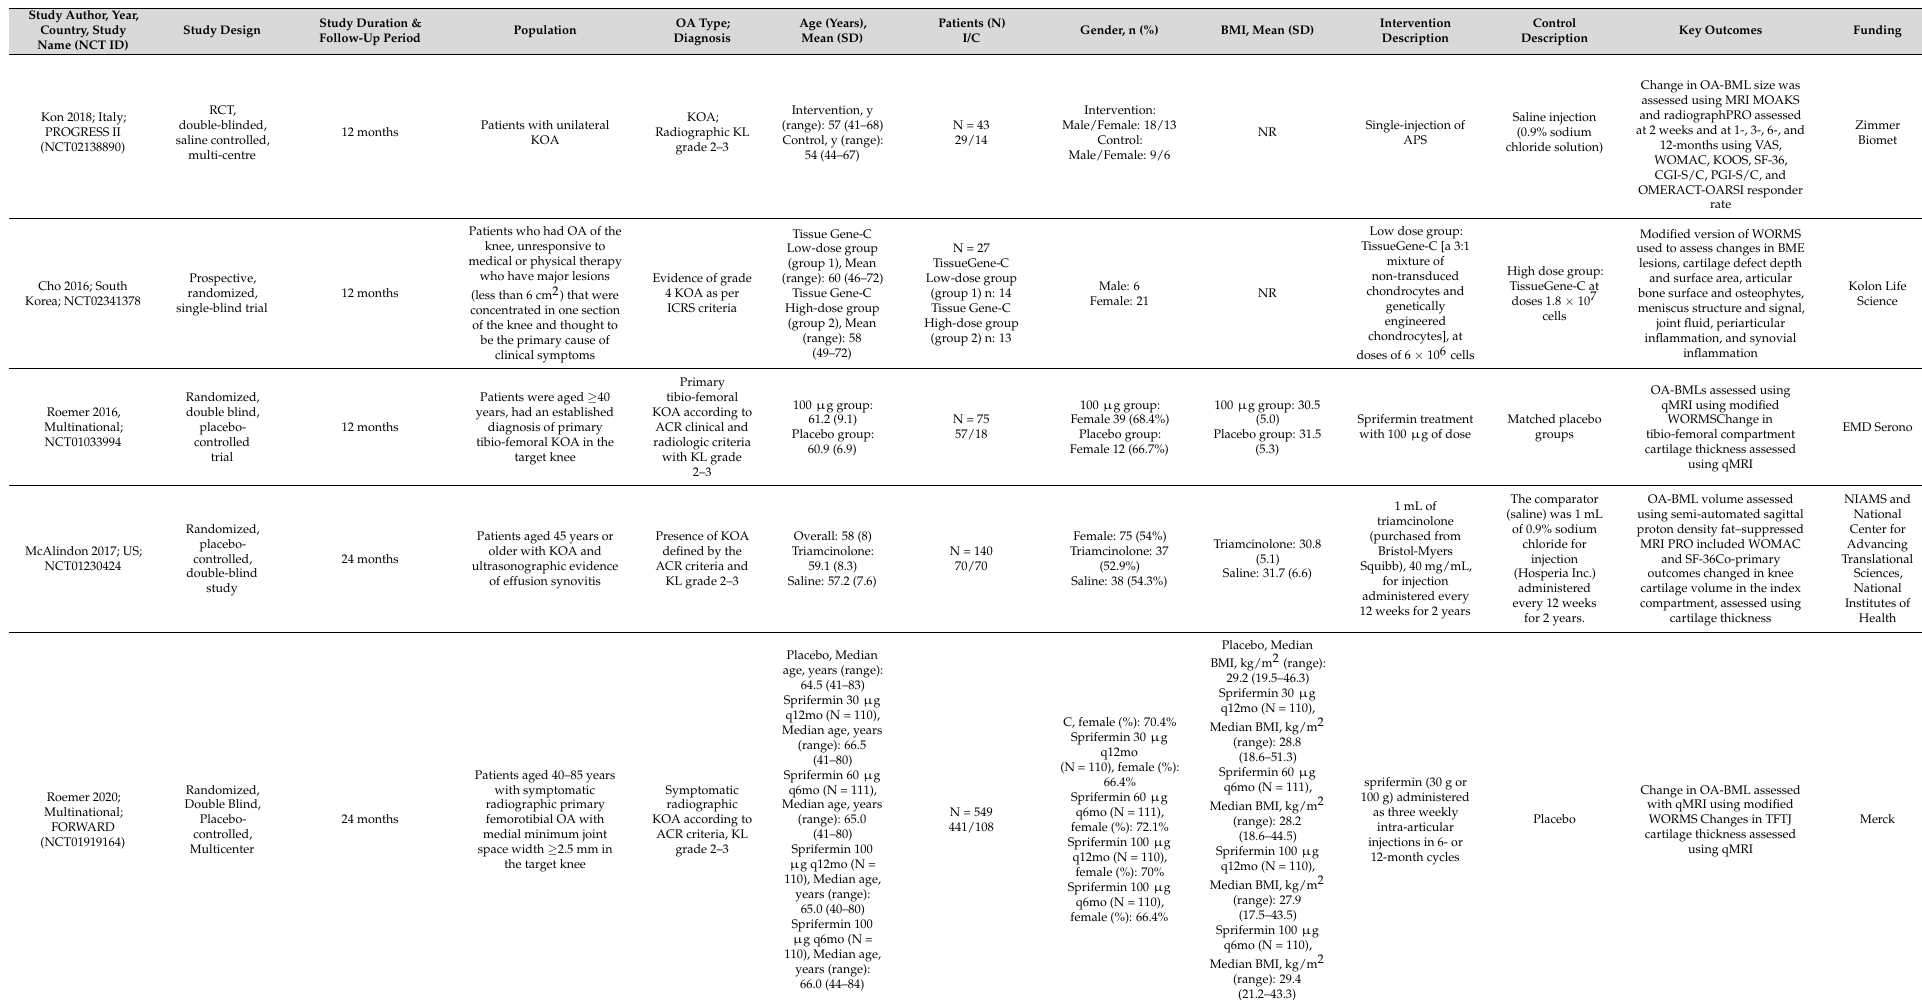
Table 1. Study design